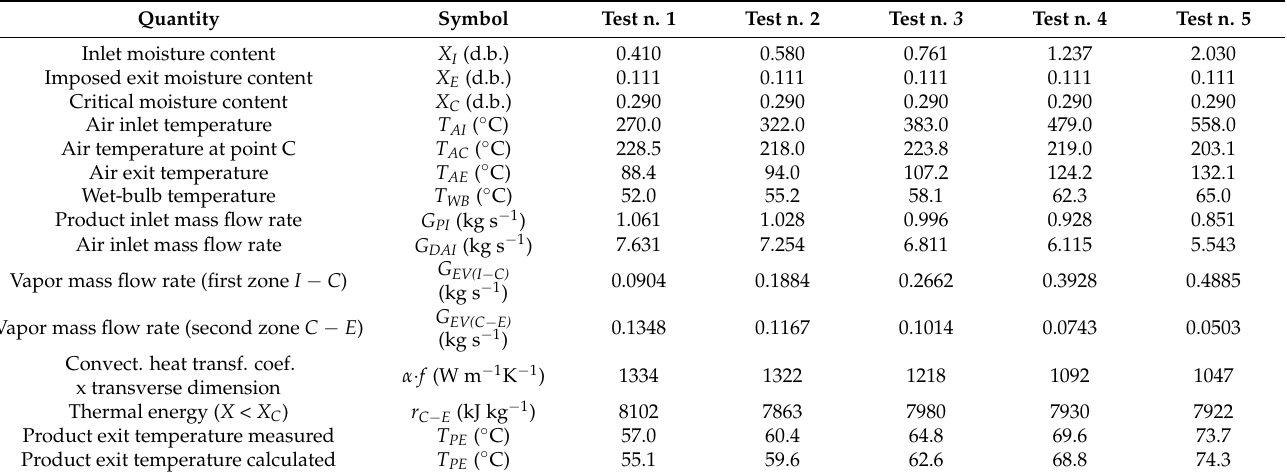
Table 4. Data simulated from the complete mathematical model used for drying control to maintain the product exit moisture content X E at a constant level (=0.111).